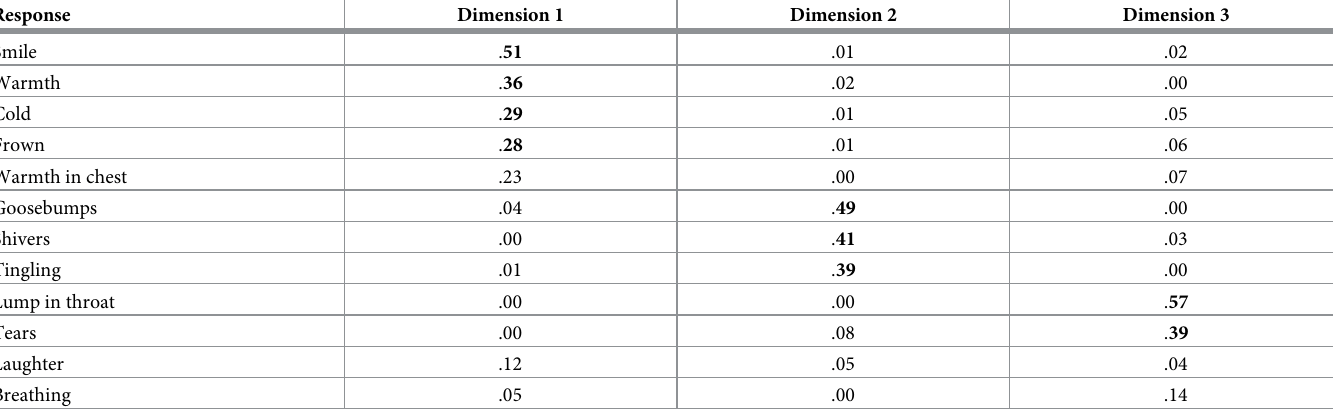
Table 2. Eta 2 values for bodily activity data on the first three dimensions of the multiple correspondence analysis (medium to large correlations are marked in bold).